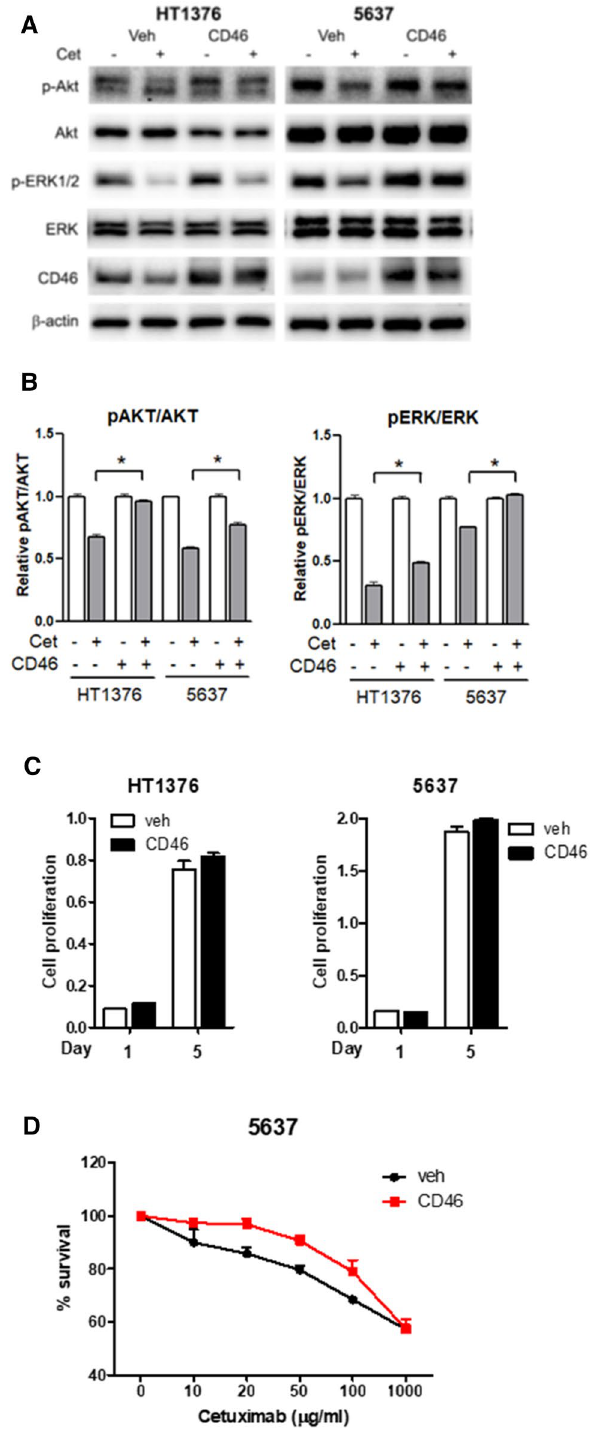
Figure 3. Restoration of the cetuximab-mediated inhibition of AKT and ERK phosphorylation by CD46. CD46 was overexpressed in HT-1376 and 5637 cells. The vehicle-loaded cells and the CD46-overexpressed cells were treated with 100 μg/ml cetuximab, incubated for 72 h, and analyzed via western blotting ( A ). Densitometric representation of relative expression of either pAKT or pERK was also shown ( B ). The MTT in vitro proliferation assay demonstrated cell growth of CD46-overexpressed cells in the absence ( C ) or presence of cetuximab ( D ). Cells were treated with cetuximab at concentrations ranging from 0 to 1,000 μg/ml for 72 h. The cells were stained with the MTT reagent, and the absorbance was measured at 570 nm. Experiments were repeated three times, and the density of each band was measured using a densitometer. Relative density of CD46 and p-AKT is shown as bar graphs. *p < 0.05 (two-tailed student